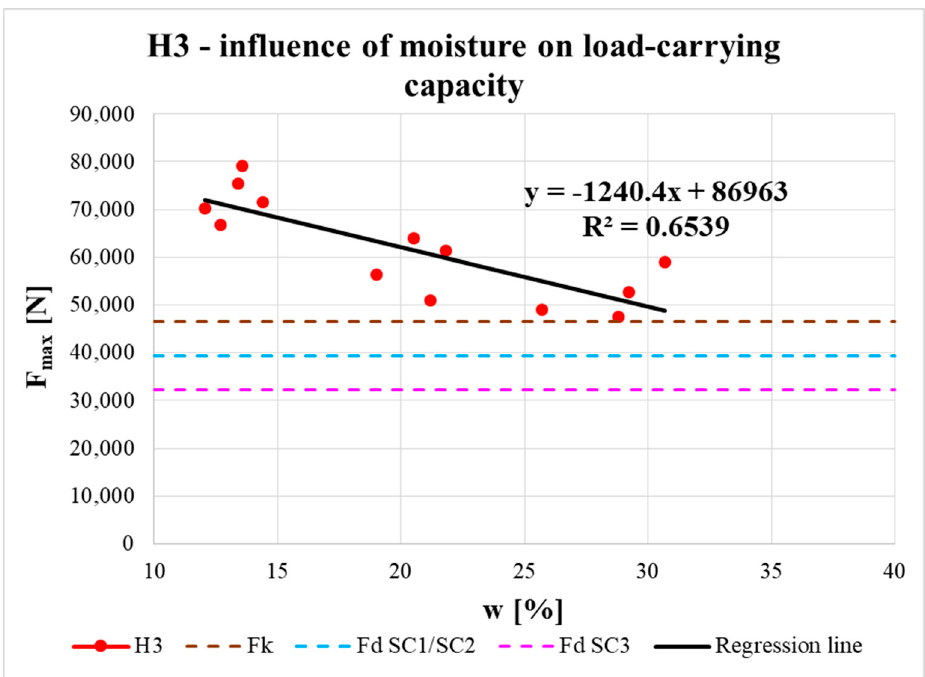
Figure 18. Influence of moisture content on load-carrying capacity of H2 specimens.